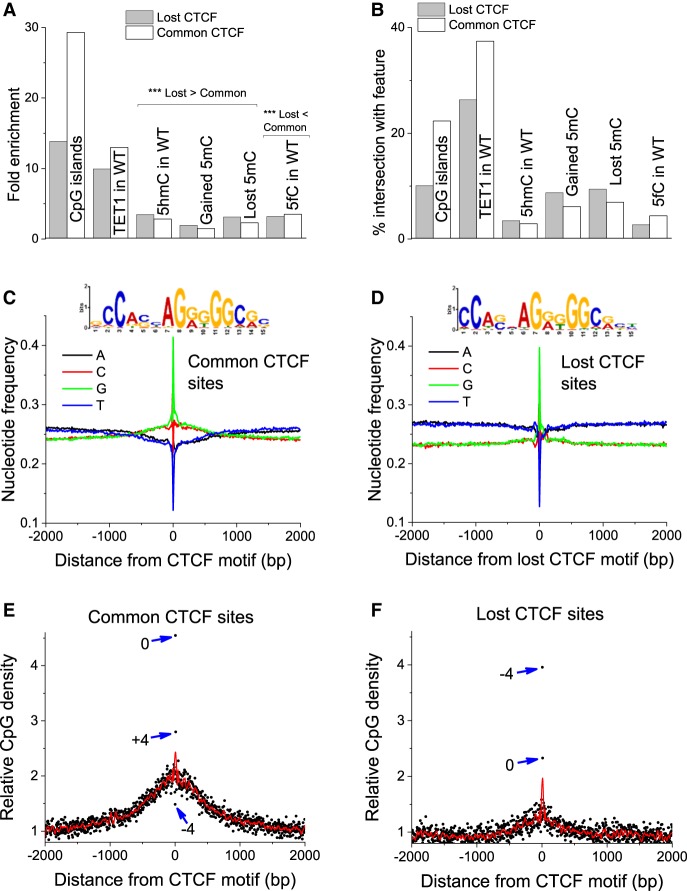
Loss of CTCF is associated with reduced GC content and CpG density. (A,B) Fold enrichment (A) and percentage overlap (B) of lost/common CTCF sites with different genomic features. CTCF sites are defined as 19-nucleotide motifs within the corresponding CTCF ChIP-seq peaks. (C,D) The nucleotide frequencies within ±2000 bp around CTCF motifs in common (C) and lost (D) peaks, as well as the corresponding consensus motifs. (E,F) CpG density around CTCF motifs in common and lost sites. Black dots correspond to individual CpG positions, red lines represent a spline interpolation of their density, and blue arrows indicate the outstanding CpGs inside the CTCF binding motif together with their coordinates with respect to the central peak of CpG density.